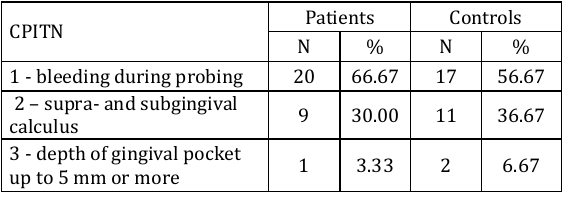
Table 3. Community Periodontal Index of Treatment Needs (CPITN) in the studied groups